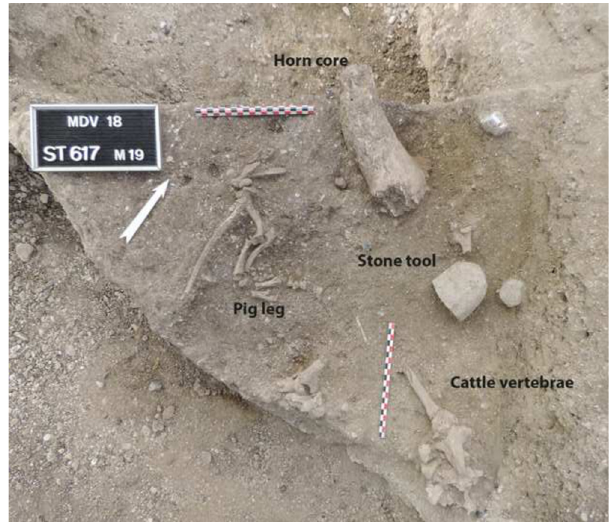
Figure 3: Menneville “ Derrière le Village. ” Example of an animal bone deposit: a cattle horn core, a piglet quarter, connected